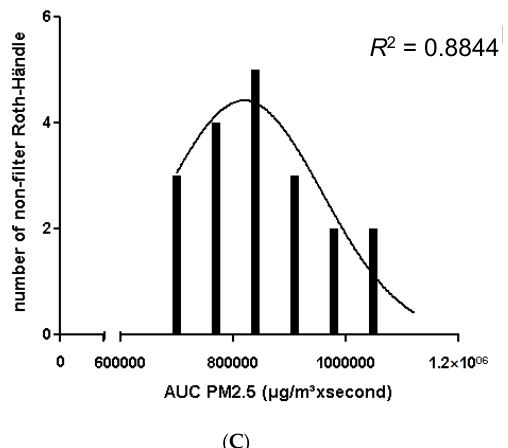
Figure 7. ( A ) Bar chart of AUC against the number of cigarettes with Gaussian curve for the 3R4F reference cigarettes; ( B ) filter-tipped Roth-Händle and ( C ) non-filter Roth-Händle.